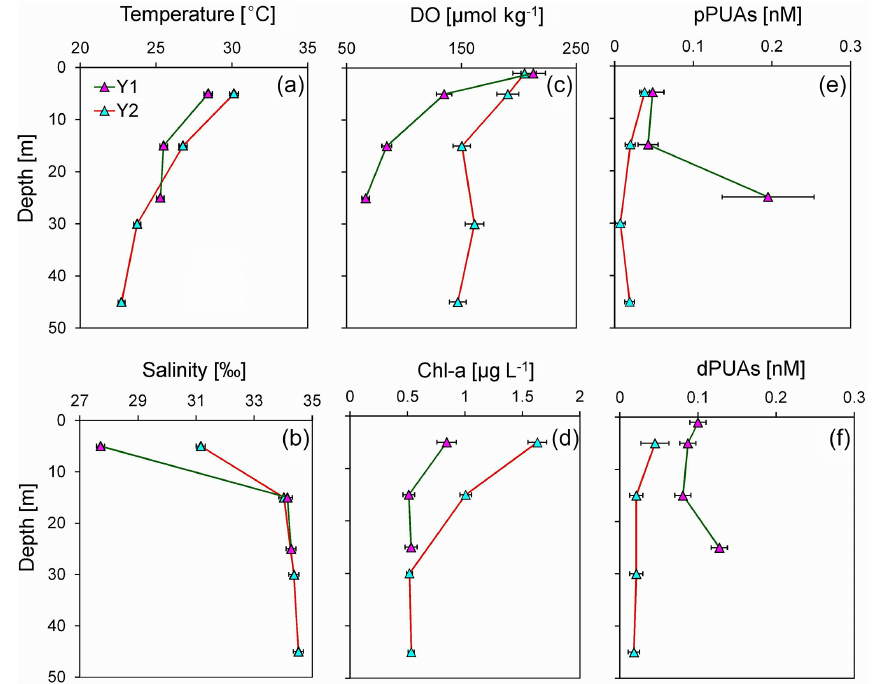
Figure 5. Vertical distributions of (a) temperature, (b) salinity, (c) dissolved oxygen (DO), (d) chlorophyll a (Chl- a ), (e) particulate PUAs (pPUAs), and (f) dissolved PUAs (dPUAs) inside (Y1) and outside (Y2) the hypoxic zone during June 2019. Locations of station Y1 and Y2 are shown in Fig. 1. Error bars are the standard deviations.